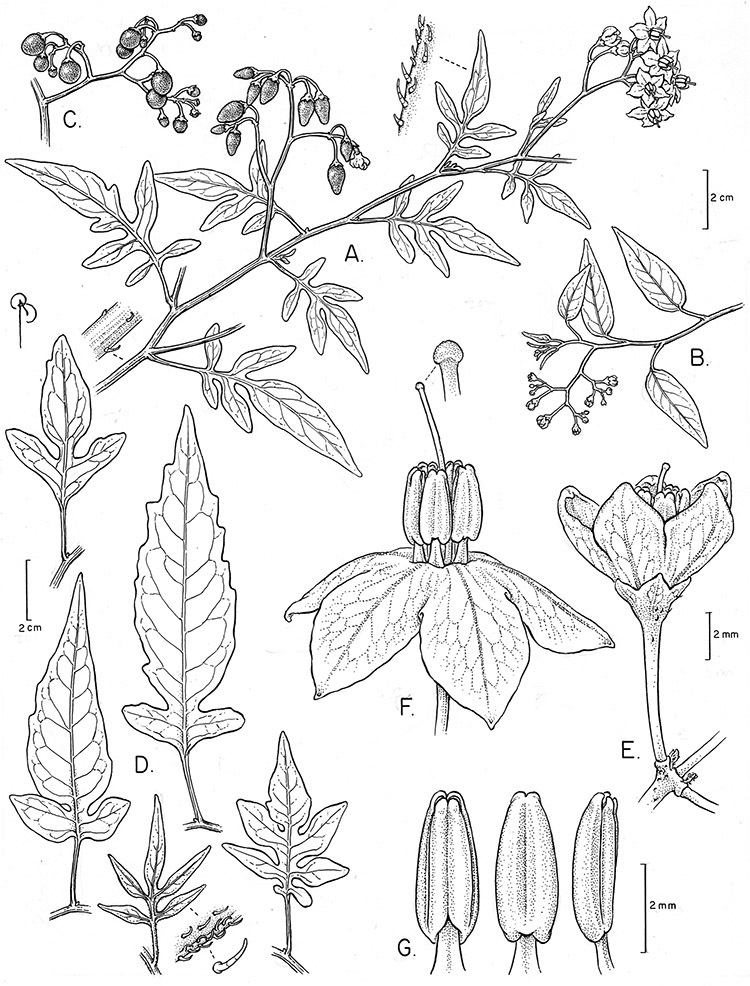
Solanum septumlobum Bunge. (A, E–G drawn from Smith 7514
B drawn from Smith 6456
C drawn from Shanxi Team 1627
D [leaf variation] from Li 930033b in addition to those cited). Illustration by Bobbi Angell.